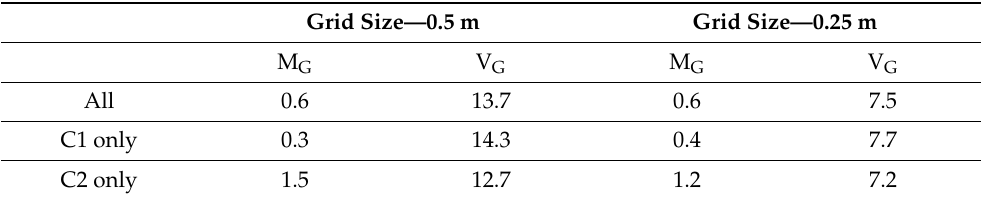
Figure 8. MV diagram showing performance of the Q9 model based on work carried out towards the Tam 2008 paper. The solid circles show results in which Q9 volumes were derived directly from experimental data (published in [2]). The crosses are results in which Q9 volumes are placed near the edge of the module. The variance of the blue cross is so large that it is outside the bound- ary of this figure. Note about legend: a line is added to the start of a new symbol to allow its easy identification.